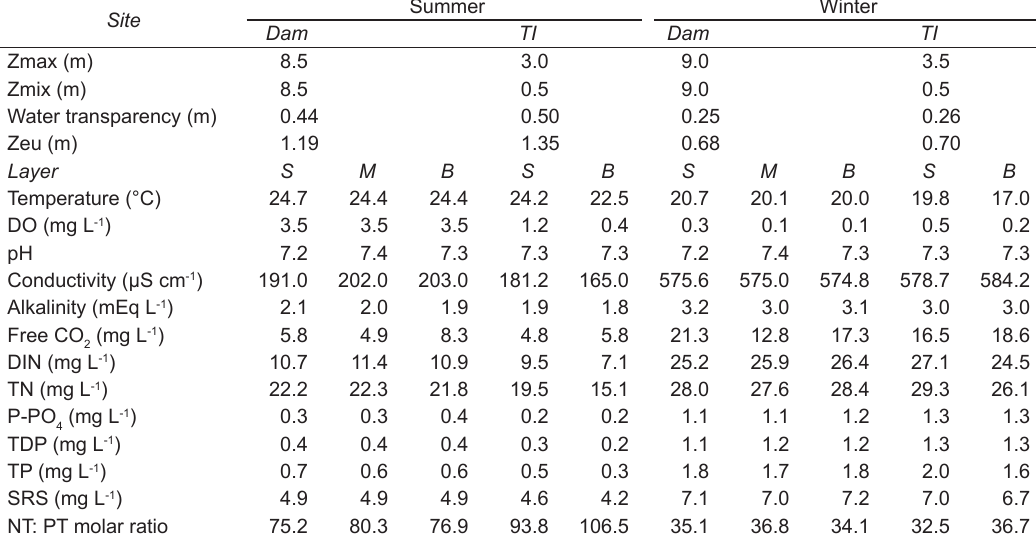
Table 1. Limnological variables in an urban hypereutrophic reservoir during the study period (Zmax: maximum depth; S: subsurface, M: middle, B: bottom; DIN: dissolved inorganic nitrogen = N-NO